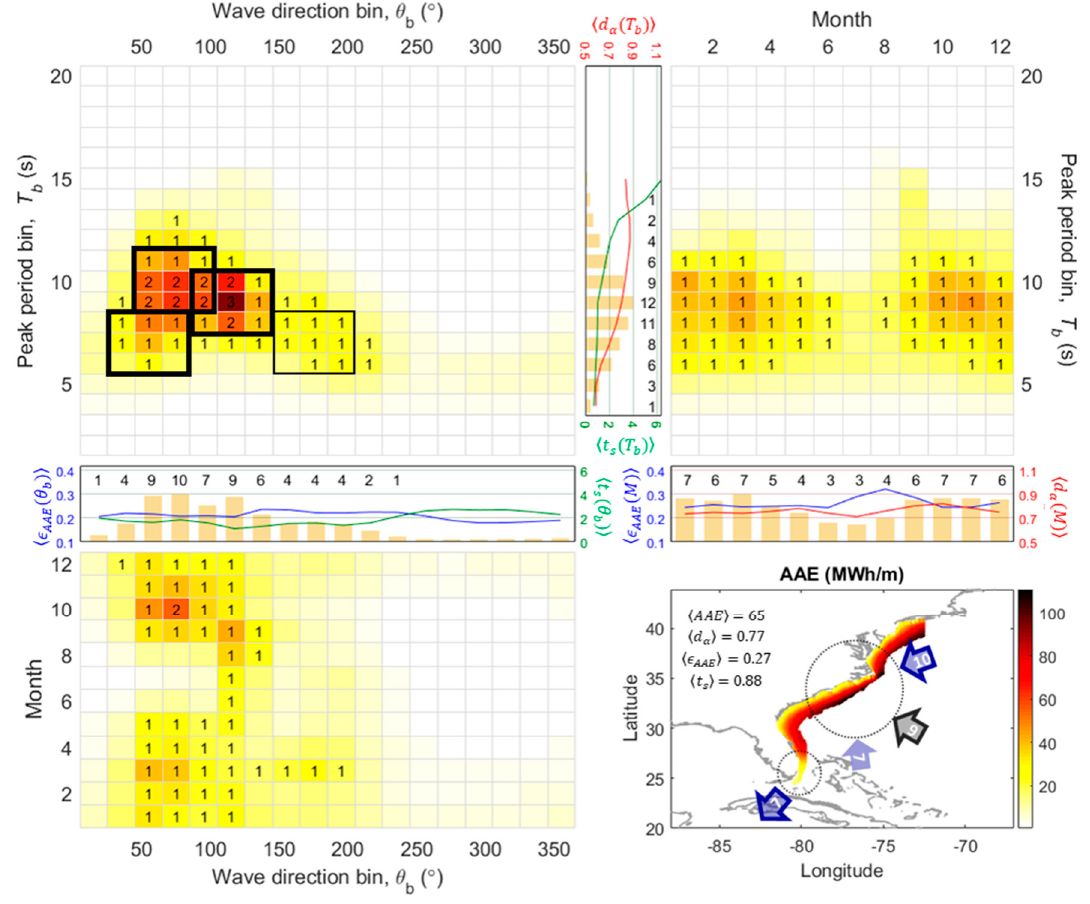
Figure 10. [Region 9: Atlantic—South and Mid-Coast] The detailed descriptions are identical to Figure 2.